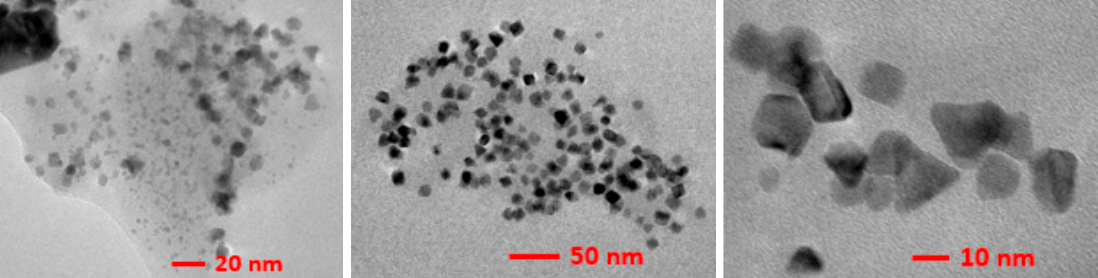
Figure 10. Morphology of C4 Pd/DNA recovered after the Suzuki–Miyaura reaction.